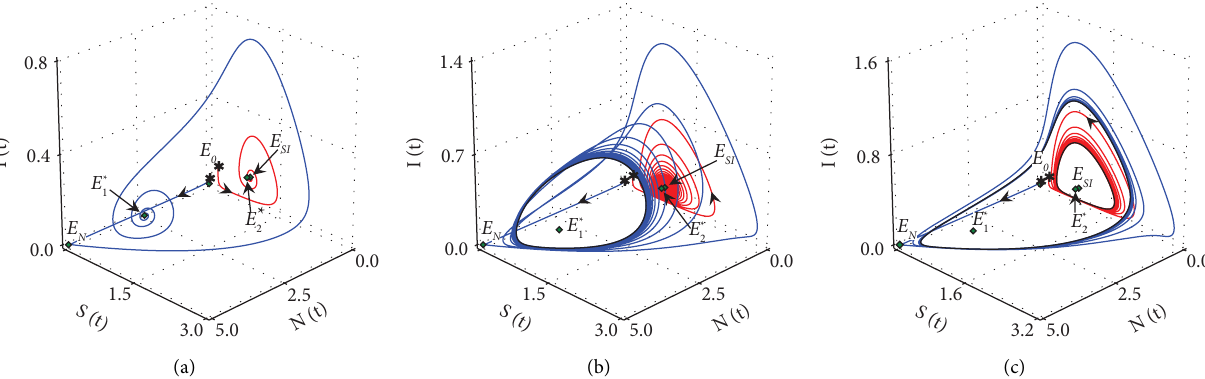
Figure 6: Te existence of two limit cycles for the weak Allee efect case with parameter values (26) and β � 0 . 22. (a) α � 0 . 85, (b) α � 0 . 96, and (c) α � 0 .